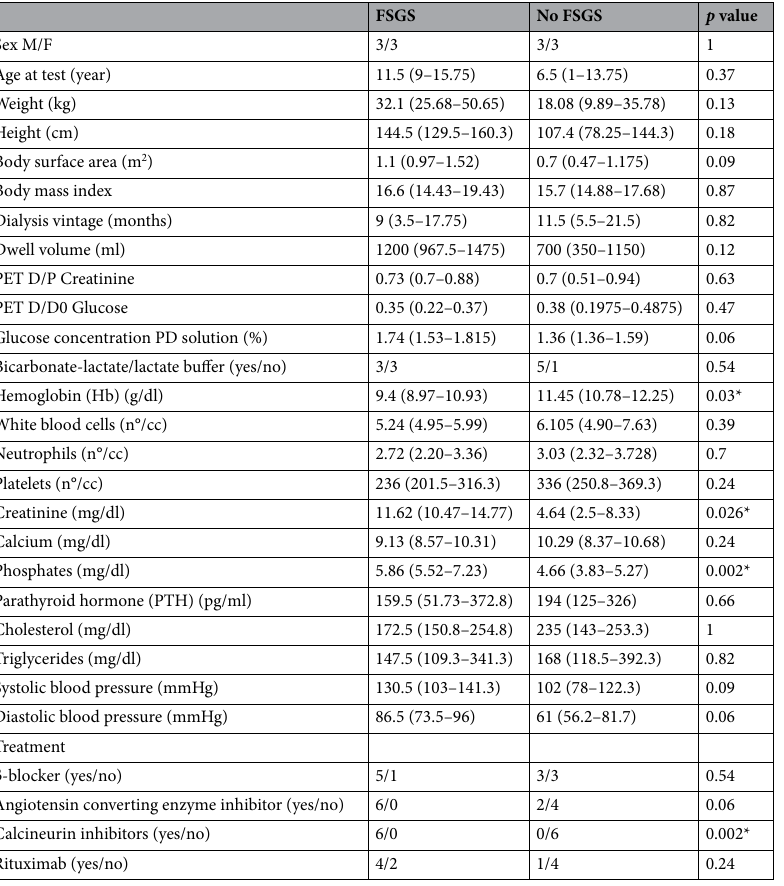
Table 2. Clinical data of FSGS and No FSGS patients. Continuous variables are reported as median and (interquartile range). Statistically differences in continuous and discrete clinical variables between FSGS and No FSGS patients were determined respectively using Mann–Whitney test or Fisher’s exact test with a 2 × 2 contingency table. Two sides p values ≤ 0.05 were considered as